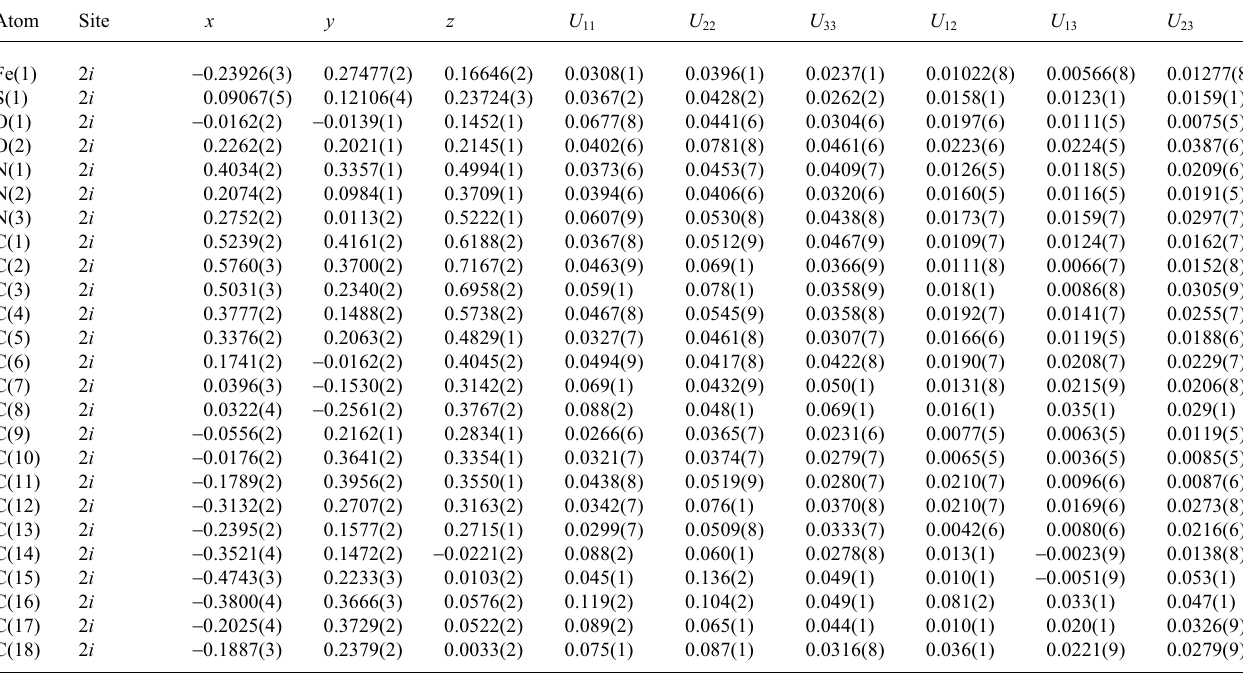
Table 3. Atomic coordinates and displacement parameters (in Å 2 )